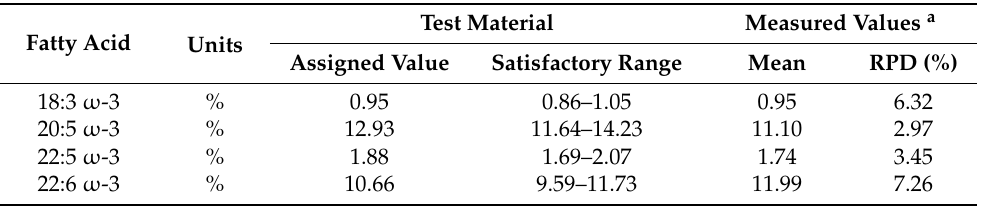
Table 3. Analysis of the fish oil test material from fapas ®